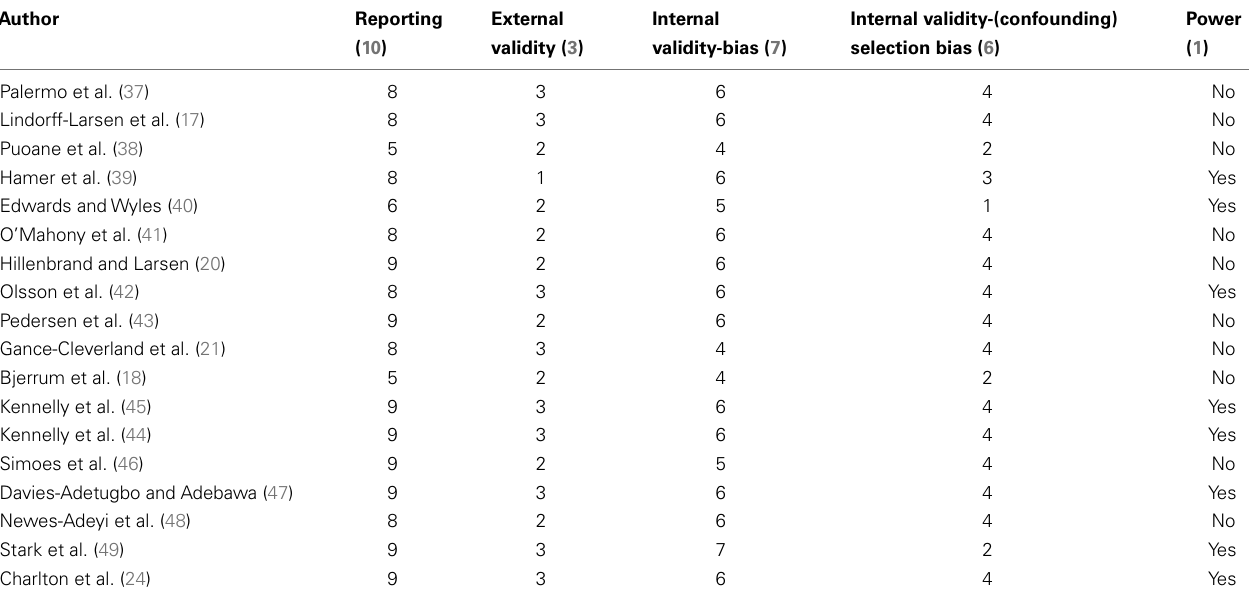
Table 3 | Risk of Bias (ROB) and methodological quality for non-randomized